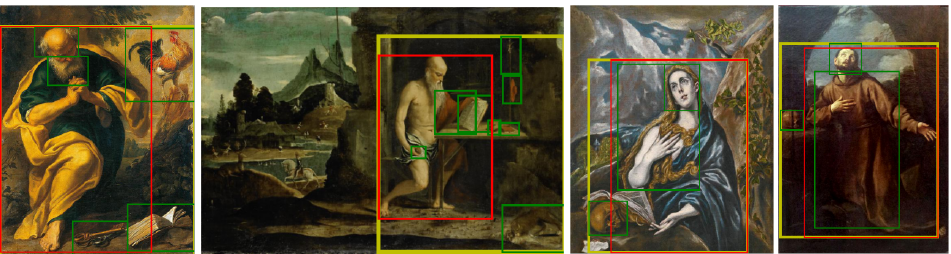
Figure 3. ArtDL 2.0 bounding boxes . The red bounding boxes contain the body of the saints and the green ones comprise individual iconography symbols associated with each Saint. The ArtDL 2.0 boxes (yellow) include both the Saint and the symbols. Table 1. The ArtDL 2.0 data set —The number of images is shown per class and per task (classification and object detection). For object detection, the number of annotated bounding boxes is reported too.